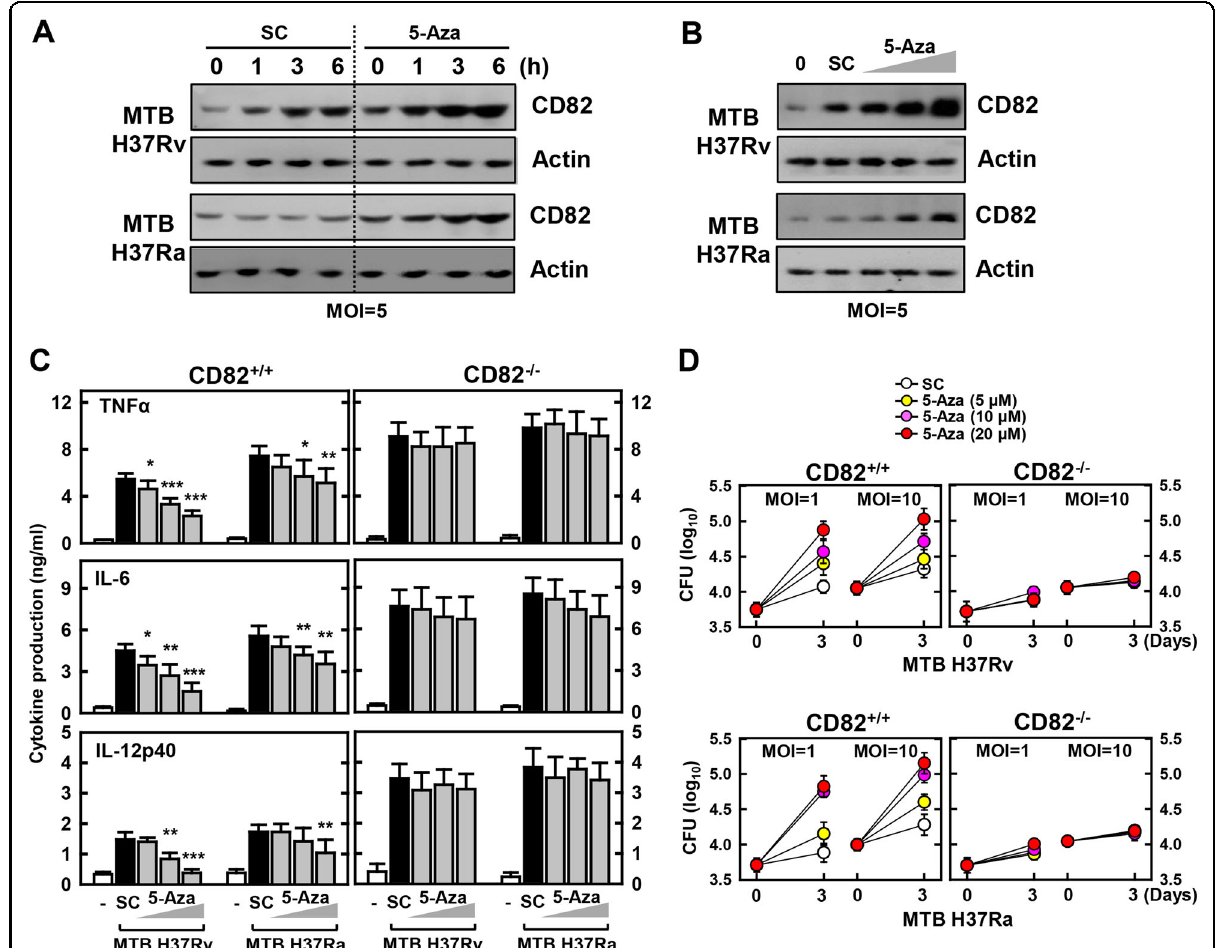
Fig. 5 DNMT inhibition induces CD82 protein expression and anti-mycobacterial responses in a CD82-dependent manner. BMDMs were pretreated with 5-Aza ( a for 10 μ M and b – d for 5, 10, 20 μ M) for 1 h and infected with MTB Rv or MTB Ra for the indicated times, followed by IB with α CD82 and α Actin ( a , b ), culture supernatant harvesting at 18 h and analysis for cytokine ELISA for TNF α , IL-6, and IL-12p40 ( c ), or intracellular survival of MTB assessment by CFU assay ( d ). The data are representative of four independent experiments with similar results ( a , b ). Data shown are the means ± SD of fi ve experiments ( c , d ). Signi fi cant differences (* P < 0.05; ** P < 0.01; *** P < 0.001) compared with solvent control (Student ’ s t- test with Bonferroni adjustment). SC solvent control 0.1% DMSO, CFU colony-forming